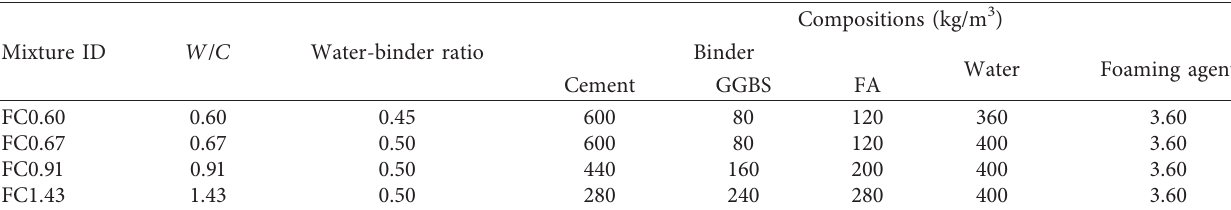
Table 5: Mixture proportions of foamed